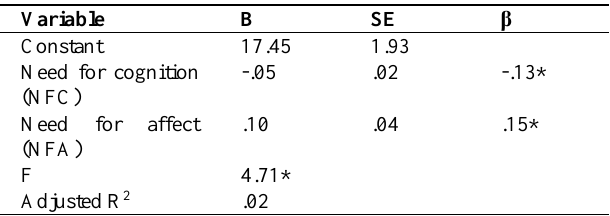
Table 4: Multiple regression analysis predicting